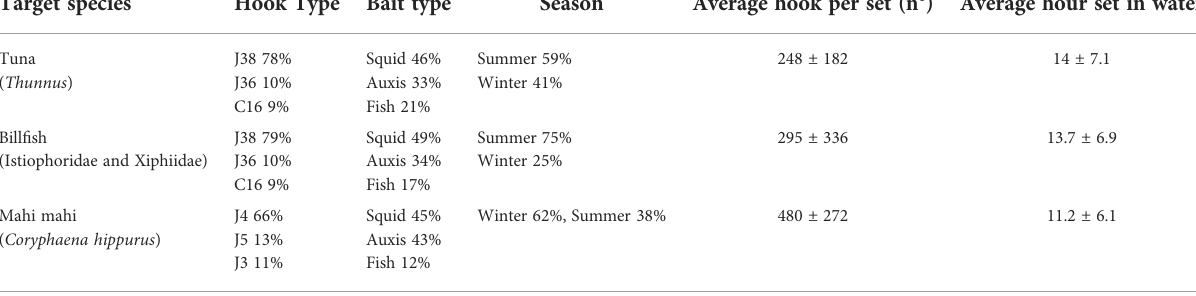
TABLE 1 Percentage of catches of the target species according to the type of hook, type of bait and season. Target